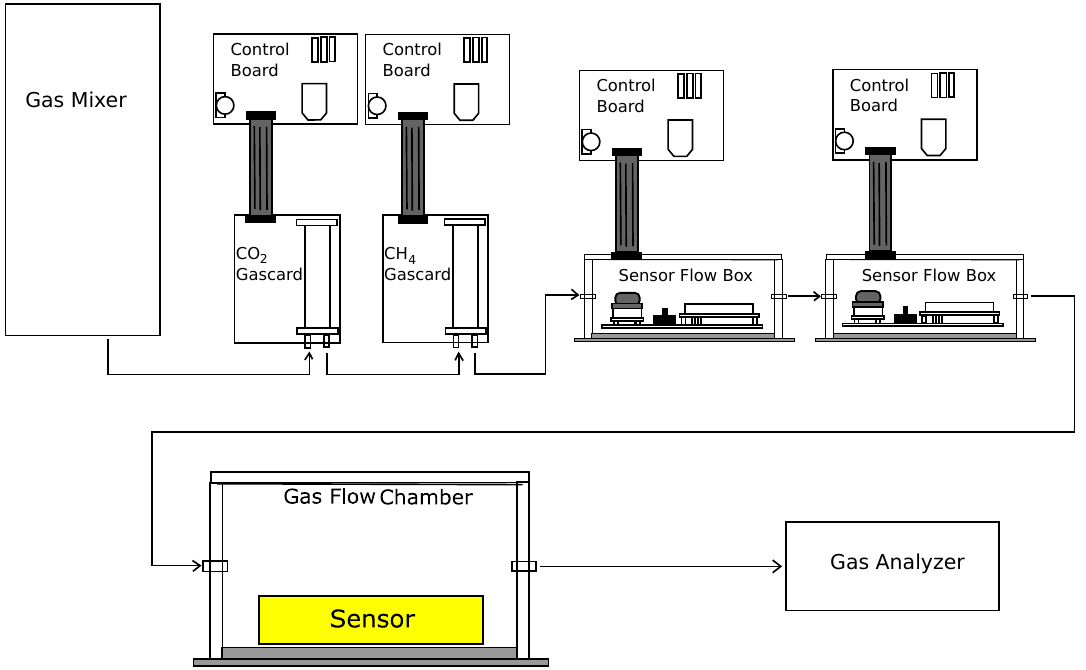
Figure 2. The diagram shows the flow of gas from the mixing apparatus to Gascard sensors, small enclosures containing sensors, the large gas flow chamber, and finally to the California Analytical Instruments, Inc. ZRE Non-Dispersive Infrared Analyzer. The gas mixing apparatus is shown in Figure 1. The reported concentrations are based on the value detected by the California Analytical Instruments, Inc. ZRE Non-Dispersive Infrared